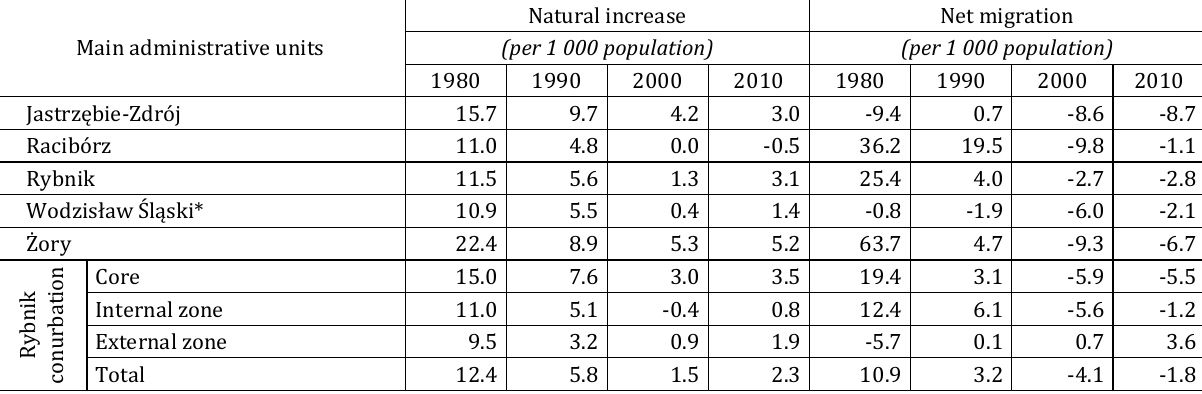
Table 2. Rate of natural increase and rate of net migration in the Rybnik conurbation, 1980–2010 (authors elaboration based on Bank Danych Lokalnych GUS; Rocznik Statystyczny Województwa Katowickiego 1981, 1991, WUS, Katowice) Natural Main administrative units